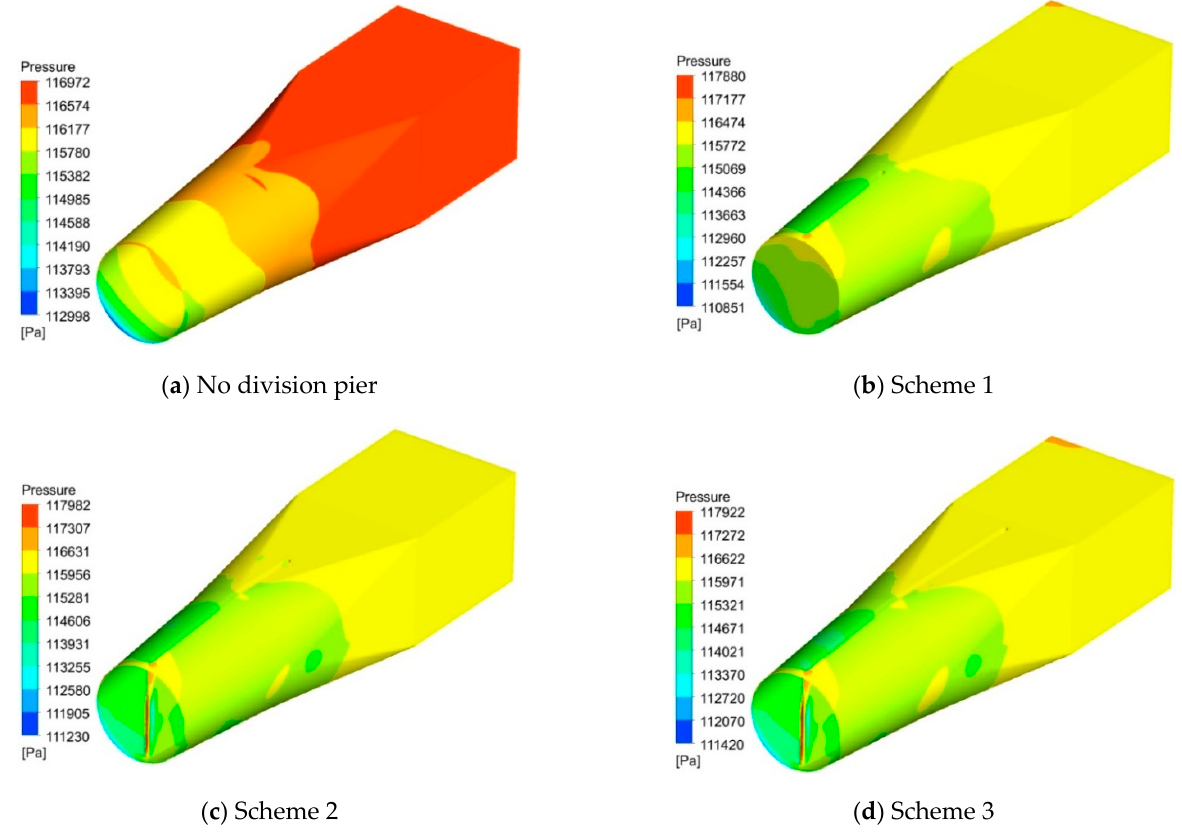
Figure 13. Pressure nephogram of the near-wall area of the straight outlet conduit.